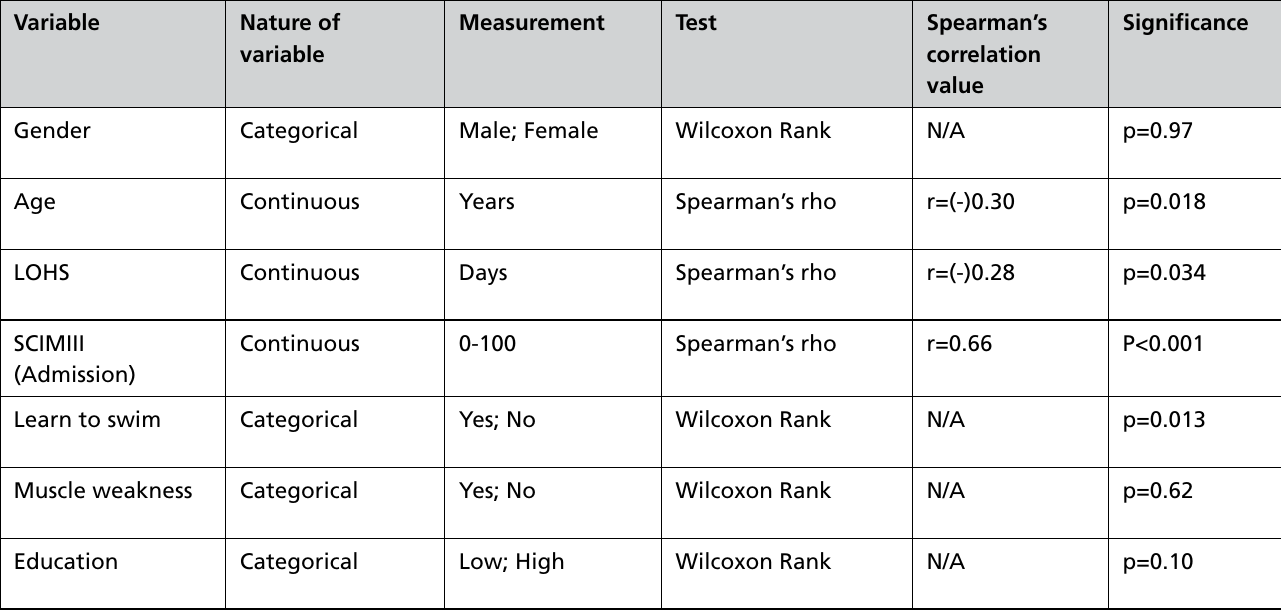
Figure 1: independent execution of tasks as derived from the sciM iii on admission and at discharge table 4: Bivariate testing of variables that could influence activity as measured by the sciM iii at discharge (n=64) Variable